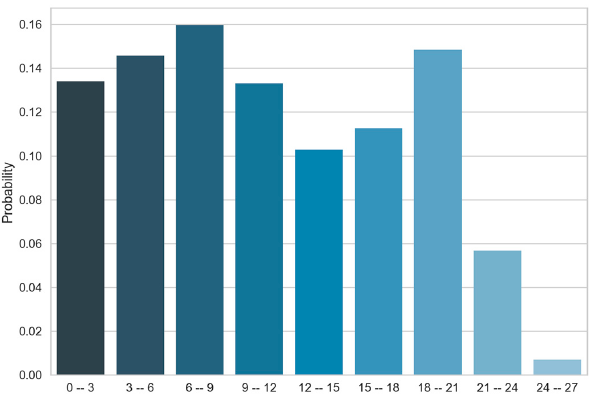
Figure 5. Probability density of the required charge of the electrical vehicle (EV) upon arrival at the ArenA.